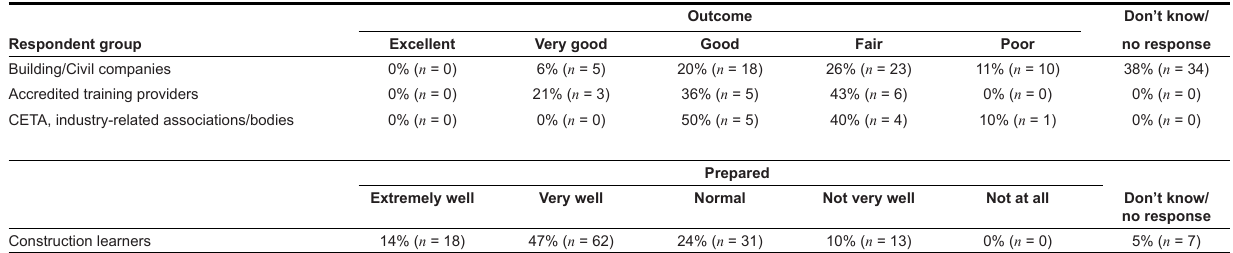
TABLE 5 Learnership outcome (overall competence/work readiness) – Across all groups